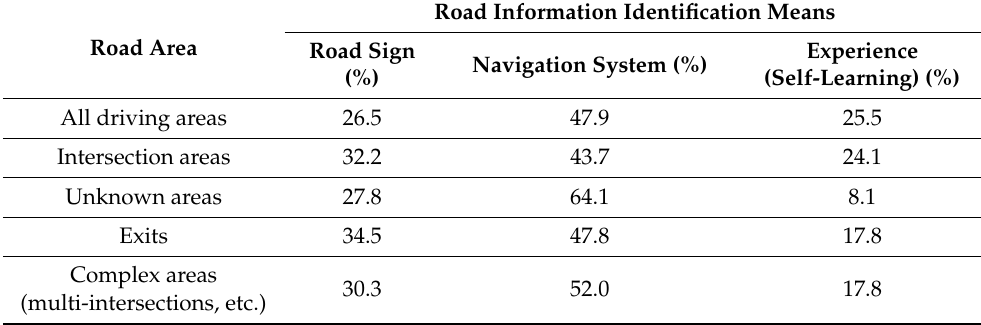
Table 2. Road information identification